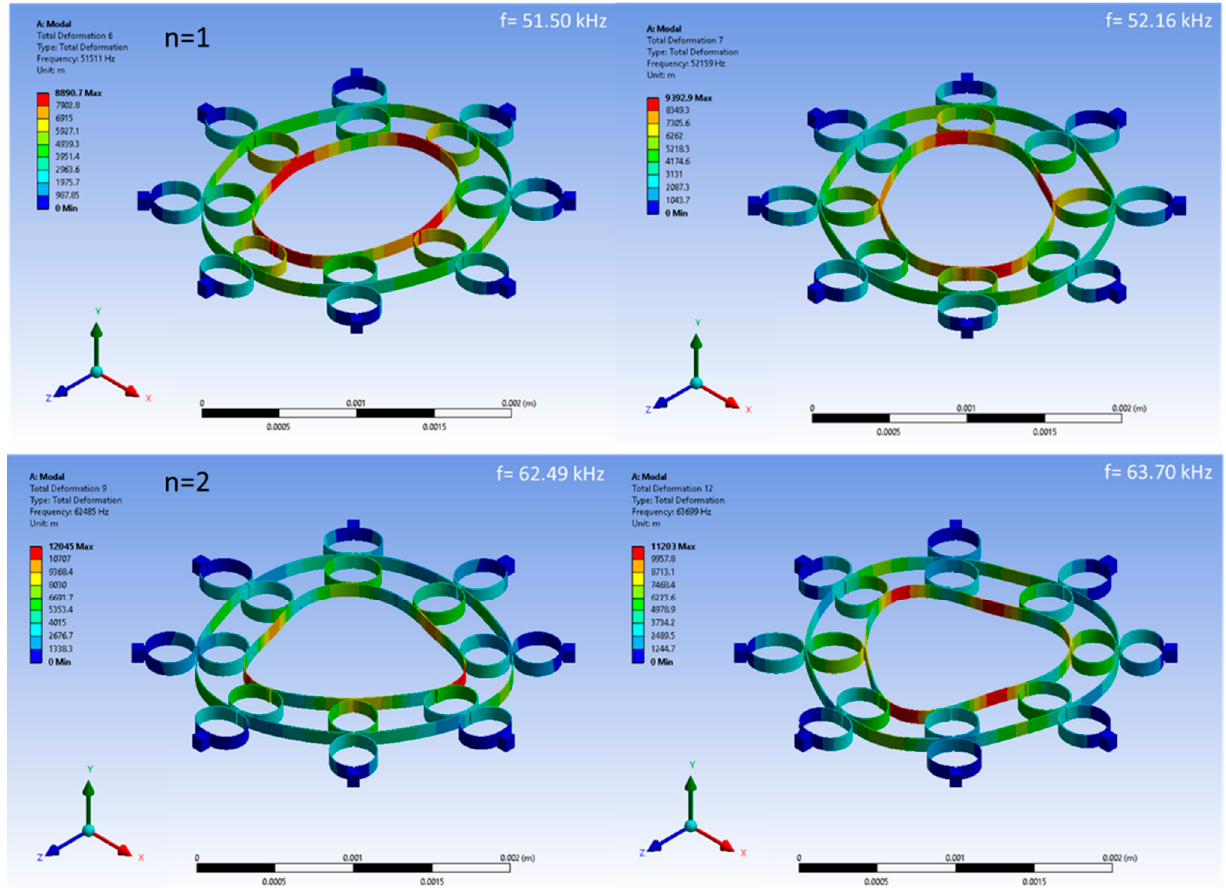
Figure 5. Modal frequencies for mode number n = 1 and n = 2.